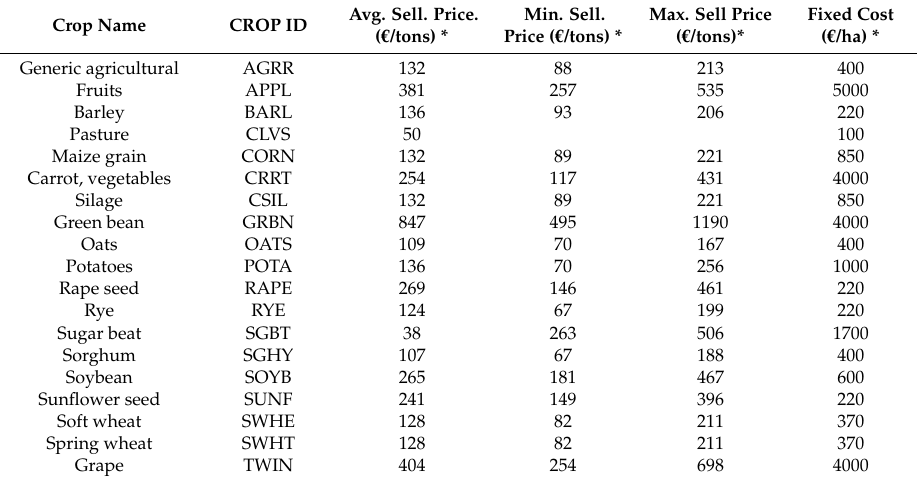
Table 3. Upper Danube Crop selling prices, management costs and mean annual simulated crop yields in the period 1995–2009 (dry weight, t/ha). The fixed cost included: total cost of machinery, labor and